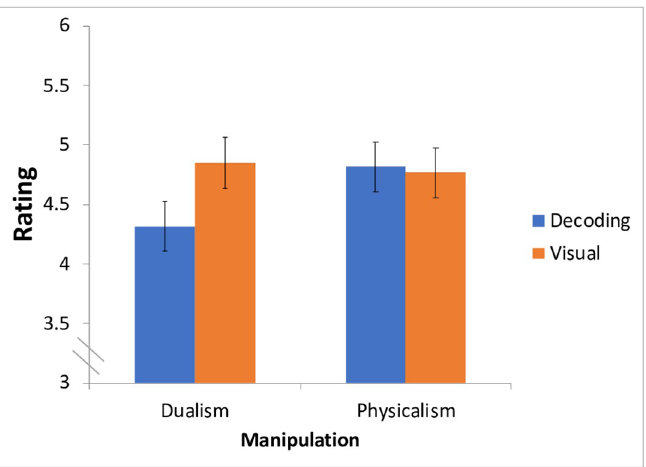
Fig 5. The effect of the mind/body manipulation on the perceived severity of dyslexia symptoms (phonological decoding and visual).